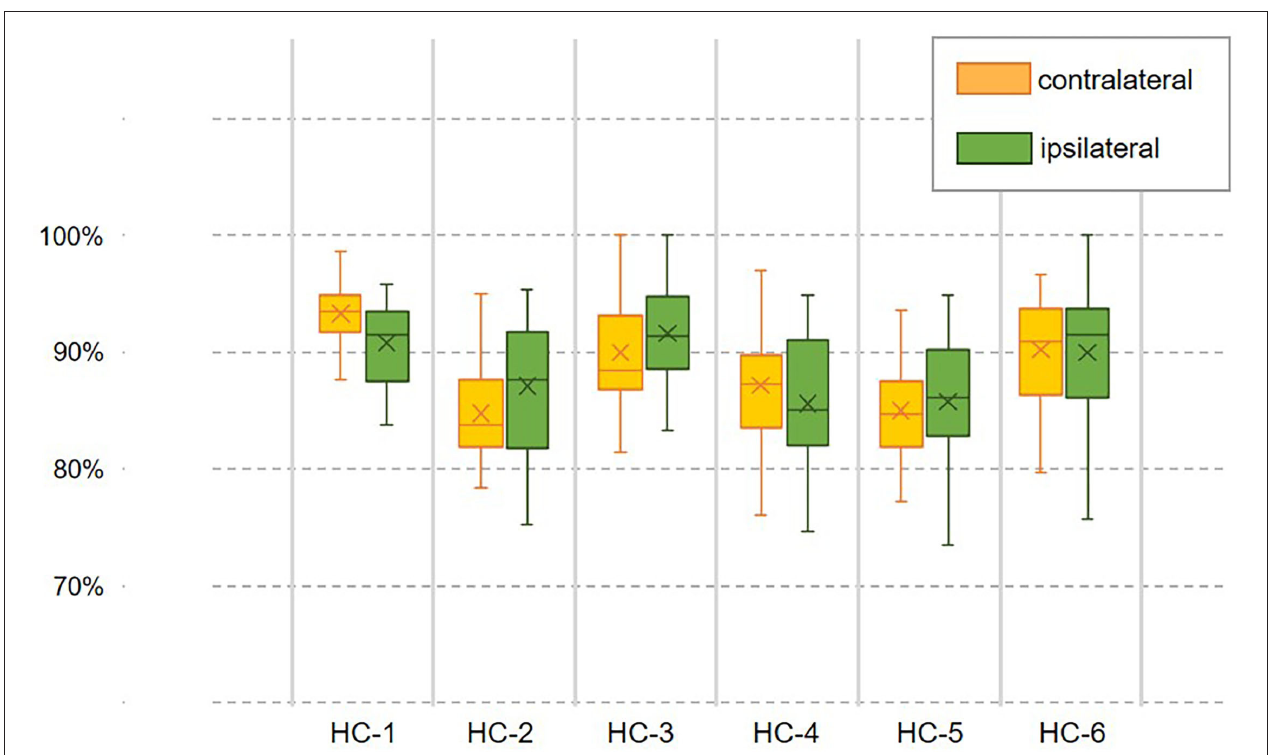
FIGURE 5 | Examination of the decoder’s speed adaptability when coordination information was introduced. The decoding accuracy with a fusion dataset containing the contralateral or ipsilateral sEMG is compared within the same person. The central trending indicates the decoder’s consistency across